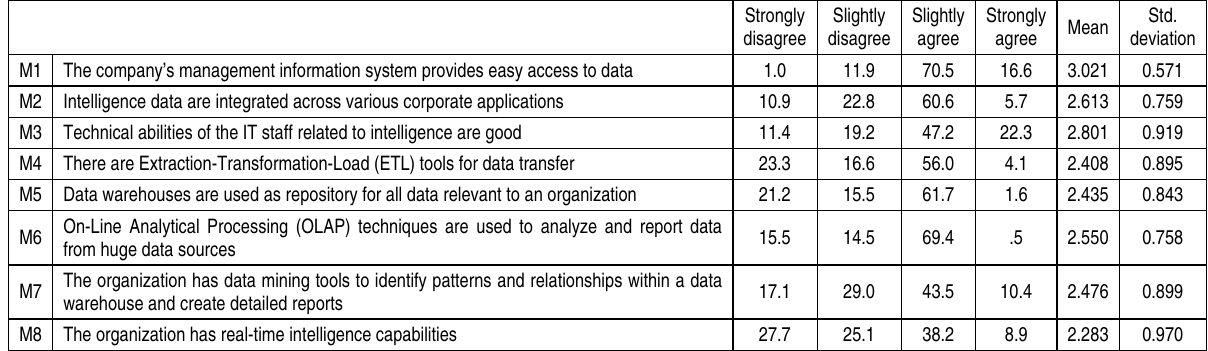
Table 4. Results of the questionnaire on information systems